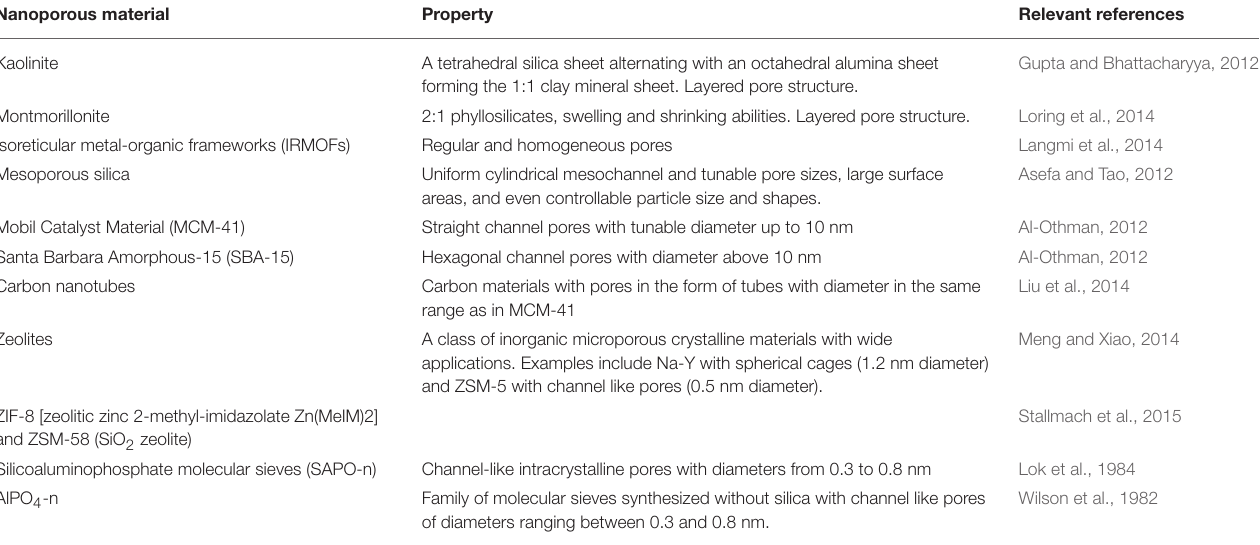
TABLE 1 | Some representative nanoporous materials discussed in the text.